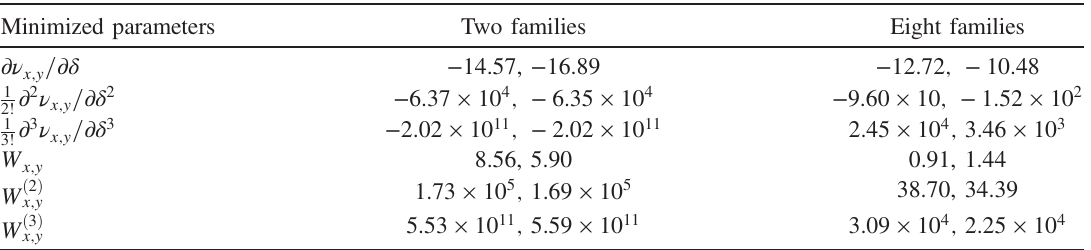
TABLE III. The nonlinear chromaticities and chromatic beatings at the IPs. Minimized parameters Two families